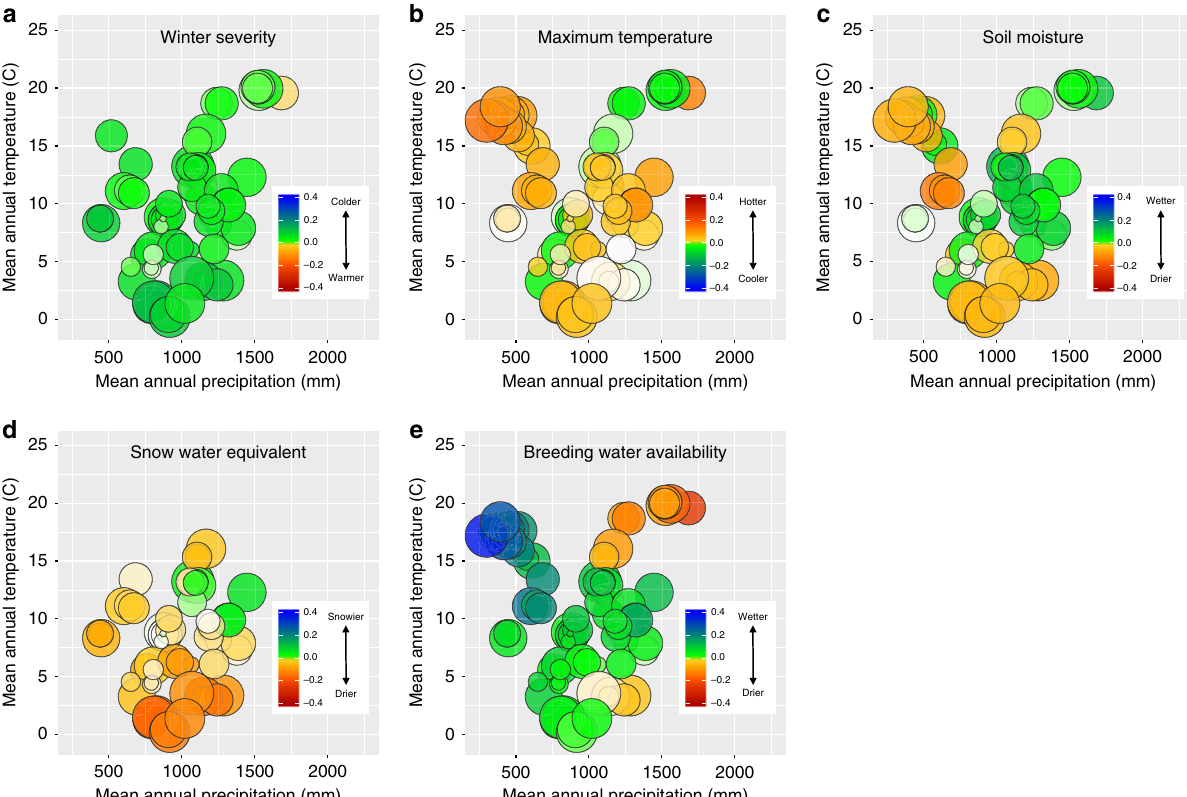
Fig. 6 Sensitivity to climate change across climatic space. We estimated how sensitive species richness was to changes in mean climatic conditions based on the estimated relationship between annual climate measures and colonization and persistence probabilities. Positive values occur when we estimated a positive change in species richness (i.e., mean species occurrence probabilities for a location) as values of the climate variable increased (i.e., more severe [i.e., cold] winters ( a ), warmer extreme summer temperatures ( b ), greater snowfall ( c ), greater soil moisture ( d ), and more water during and immediately prior to breeding ( e )). Negative values represent a predicted decline in local species richness with a shift to higher values of the climate variable. Cool colors (greens and blues) denote that the species richness responds positively to either cooler or wetter conditions, depending on the climate variable. Warm colors (yellow, orange, red) denote that species richness responds positively to warmer or drier conditions for the climate variable. Circle sizes are proportional to the sample size for the study area (number of unique species, site, and year combinations). Missing values occur for snow water equivalent and winter severity for warmer areas where snowfall and days with mean temperature less than 0 were minimal. We did not measure the effect of breeding water availability for species only measured in terrestrial plots, where surveys were not timed with peak breeding